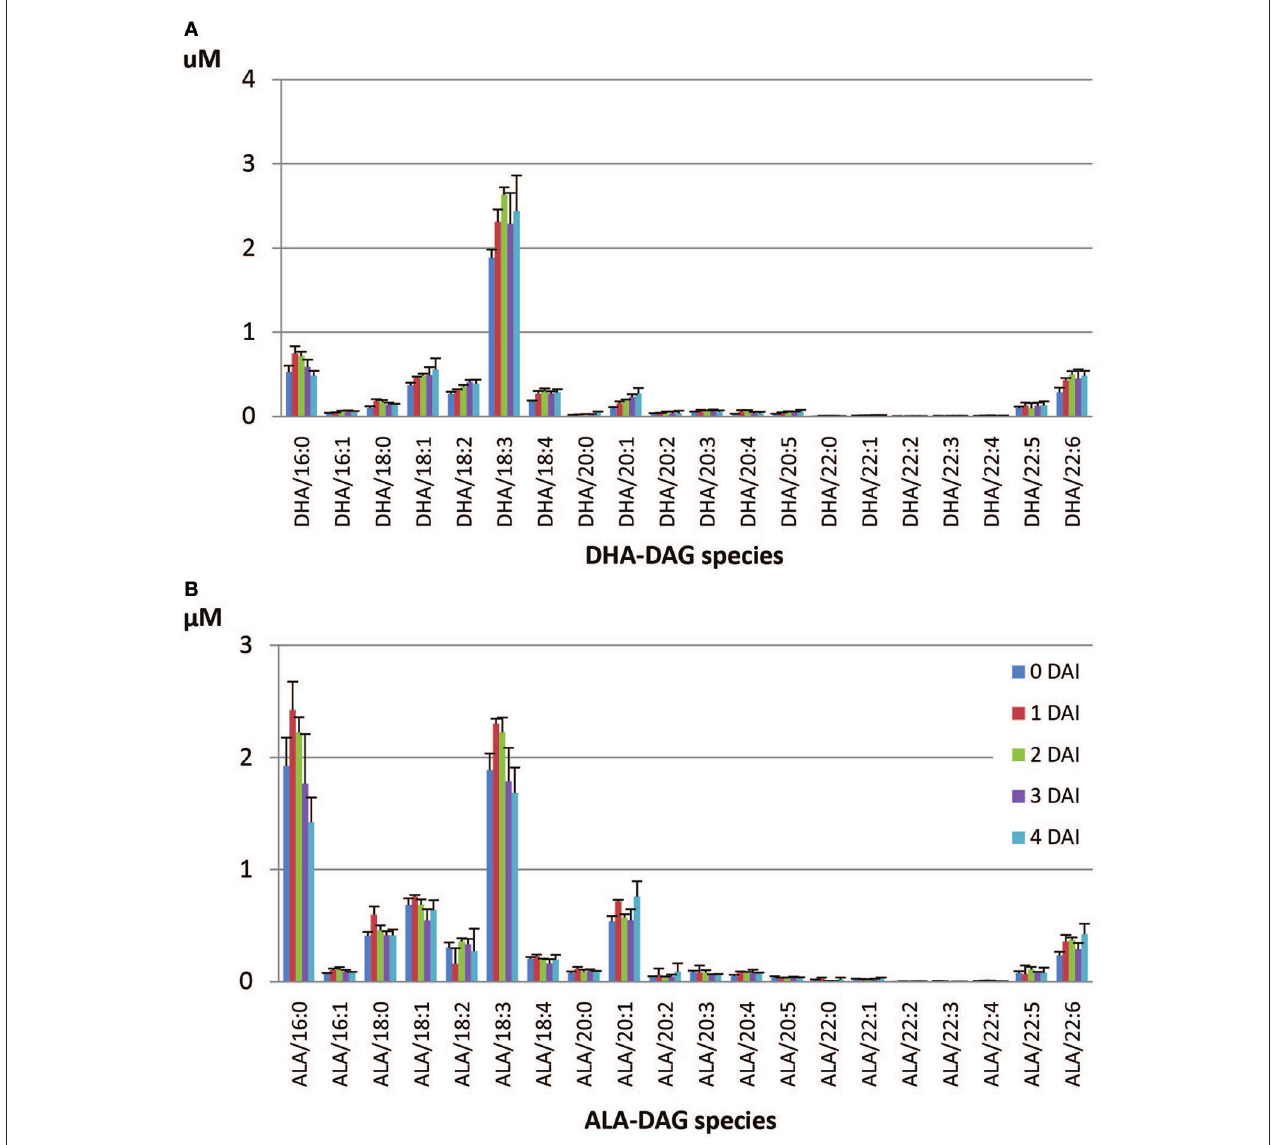
FIGURE 7 | Accumulated DAG species during seedling development in the DHA-line. (A) DHA-containing DAG species, (B) ALA-containing DAG